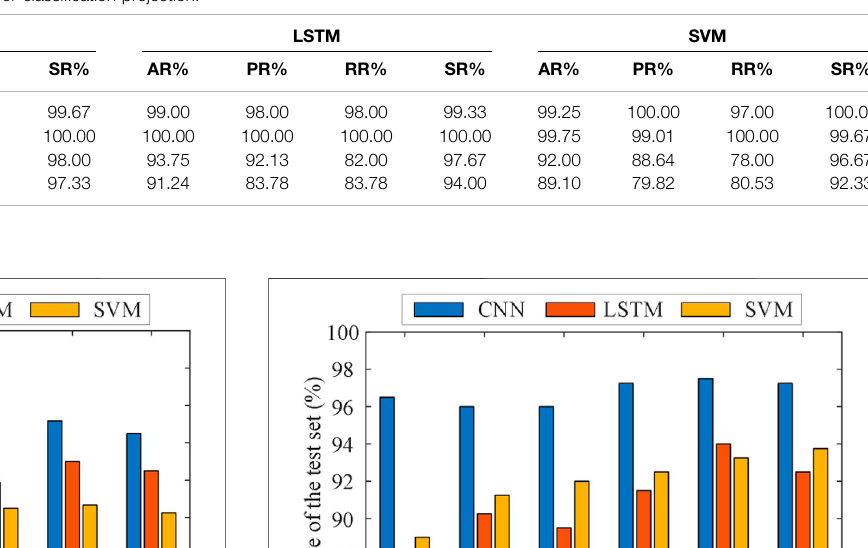
TABLE 2 | Comparison of performance indicators for classi fi cation projection.